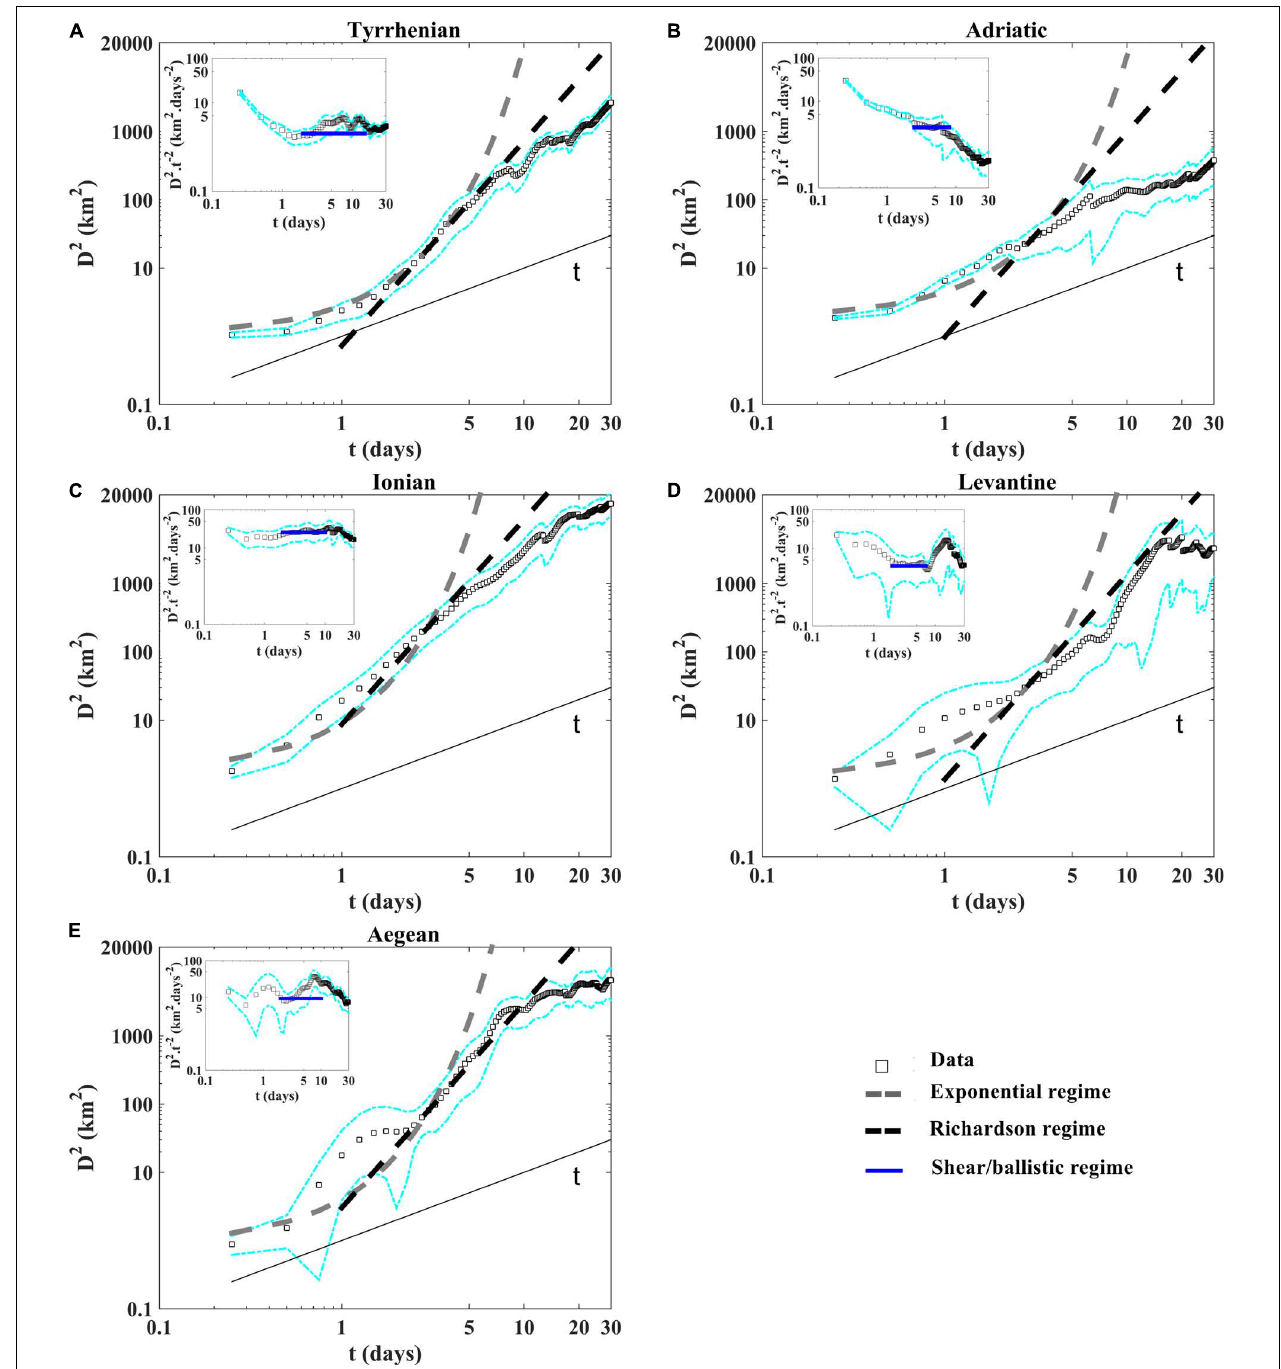
FIGURE 7 | Relative dispersion as a function of time in loglog plot (A) in the Tyrrhenian, (B) the Adriatic, (C) the Ionian, (D) the Levantine and (E) the Aegean sub-basins. The exponential and the Richardson regimes are shown with the dashed gray and black lines, respectively. The diffusive regime is shown with the thin black line. In the insets we show the relative dispersion normalized by the squared time t 2 would have a plateau (horizontal blue lines) for the occurrence of the shear/ballistic regime. The dashed cyan lines indicate the 90% confidence intervals from bootstrap resampling, give a rough idea of the uncertainties for the